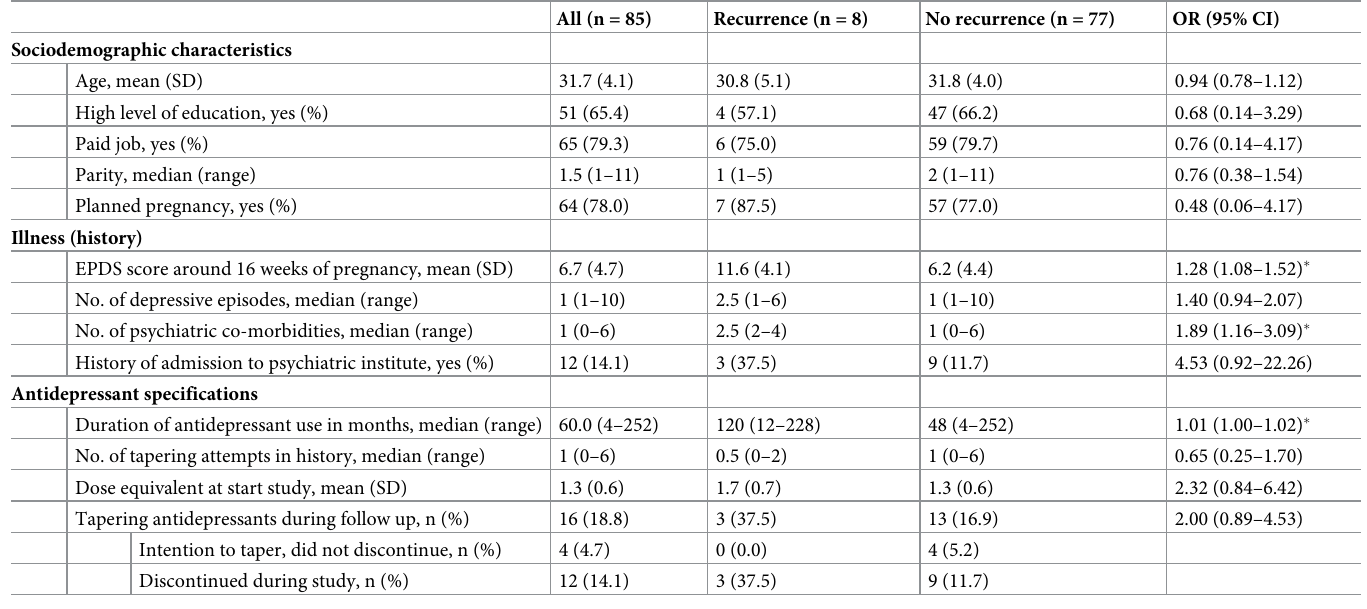
Table 1. Characteristics of pregnant women with a history of depression, with and without recurrence of depression during the perinatal